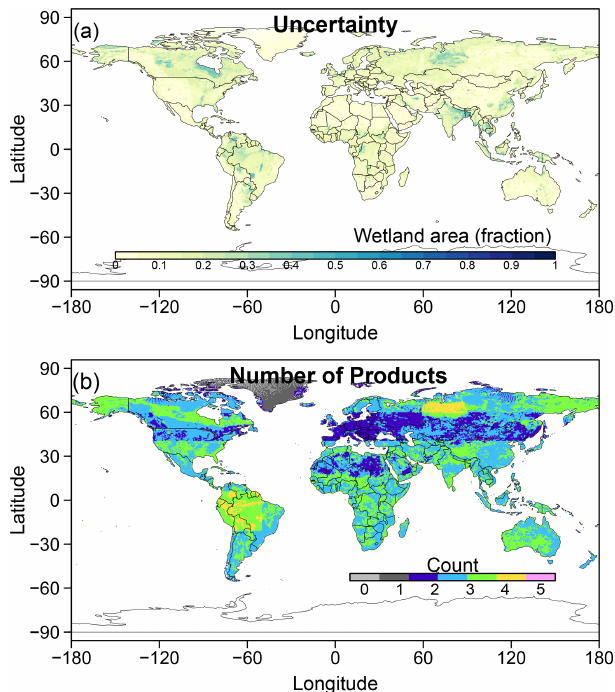
Figure 9. Uncertainty (1 σ ) of annual maximum wetland area (MA max ) across data sources. The data sources used in the calcula- tion are WAD2M, GIEMS2, GLWD, CIFOR and CAWASAR, NC- SCD, Toochi2019, Terentieva et al. (2016), and Hess et al. (2015). (a) Spatial distribution of uncertainty in wetland fraction. (b) Num- ber of products used in the